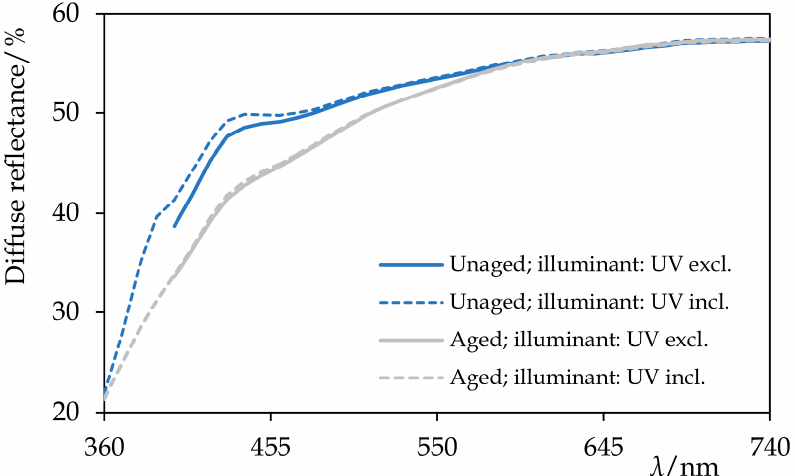
Figure 12. The diffuse reflectance spectra of Permulgin 3274 before and after the artificial ageing by the exposure to UV-vis radiation for 240 h. Information about the illuminant used during the acquisition of the spectra is given. Note the yellowing and the decrease in the fluorescence of the aged